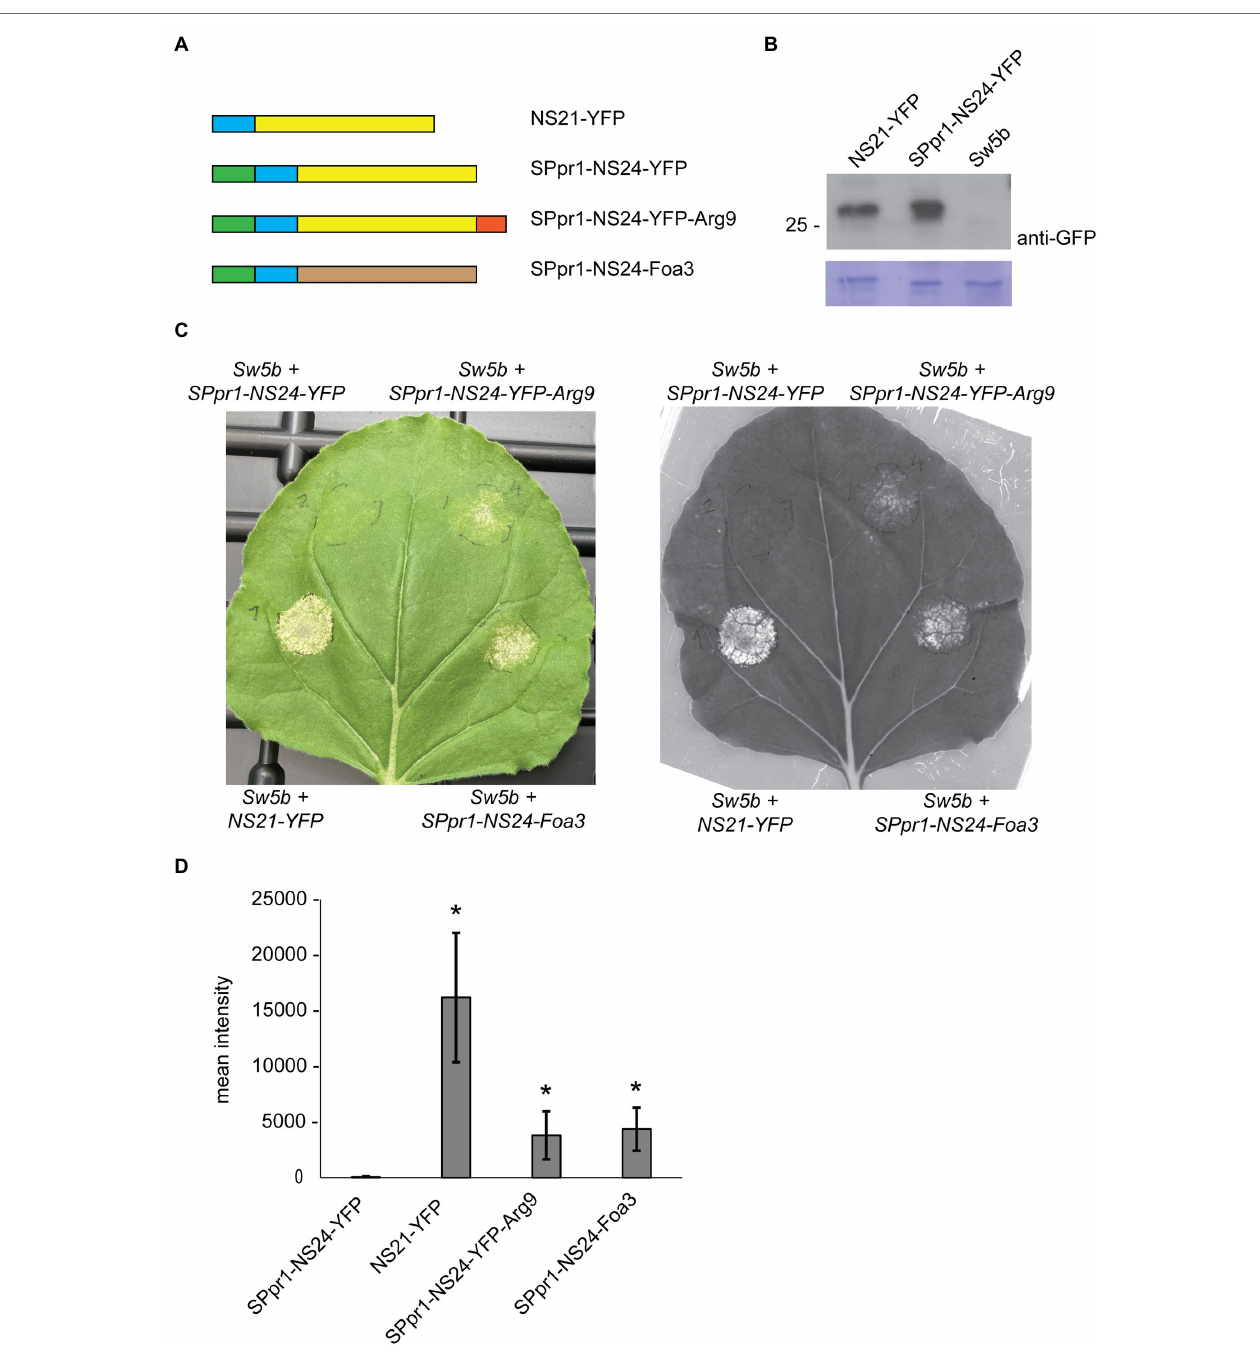
FIGURE 3 | Foa3 can deliver an avirulence protein of tomato spotted wilt virus into host cells. (A) Schematic representation of the constructs used in Nicotiana benthamiana Agro-infiltration experiments. NS21/24 (blue), YFP (yellow), PR1 signal peptide (green), Arginine 9 (red) and Foa3 (brown) are shown. (B) Anti-YFP Western blot showing similar accumulation levels of NS21-YFP and SPpr1-NS24-YFP in Agro-infiltrated Nicotiana benthamiana leaves. Molecular weight (kDa) markers are shown on the left. Equal loading is verified by Coomassie staining of the blots. (C) Sw-5b triggered cell death in Nicotiana benthamiana leaves expressing the indicated constructs. A representative leaf is shown upon regular photography (left) or following red fluorescence imaging using a Chemidoc imager (right). Images were taken 5 days after Agro-infiltration. (D) Signal quantification of red fluorescence imaging of Nicotiana benthamiana leaves producing the indicated constructs. Statistically significant differences to the SPpr1-NS24-YFP construct are indicated ( p < 0.05, t -test, n = 6 leaves). Experiments were repeated at least three times with similar